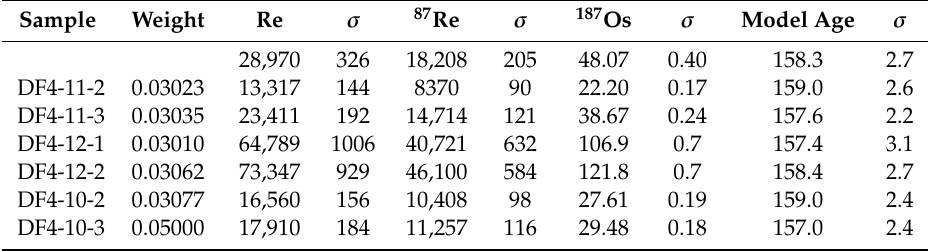
Table 2. Re–Os isotopic data for molybdenites from the Jiangjiatun Mo deposit.